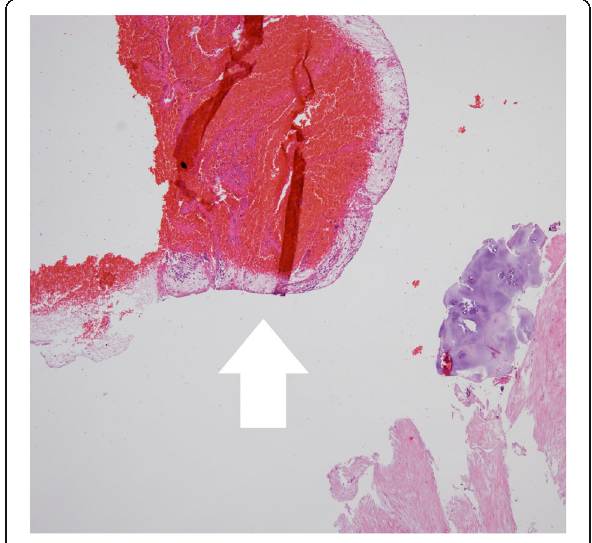
Fig. 3 Hematoxylin and eosin stain, 40×. Photomicrograph shows a lot of red blood